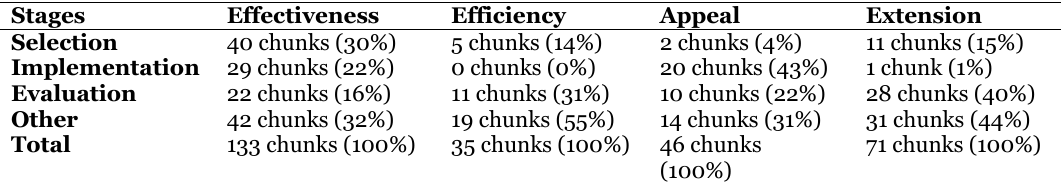
Important Instructional Priorities for OER Use at Three Stages of OER